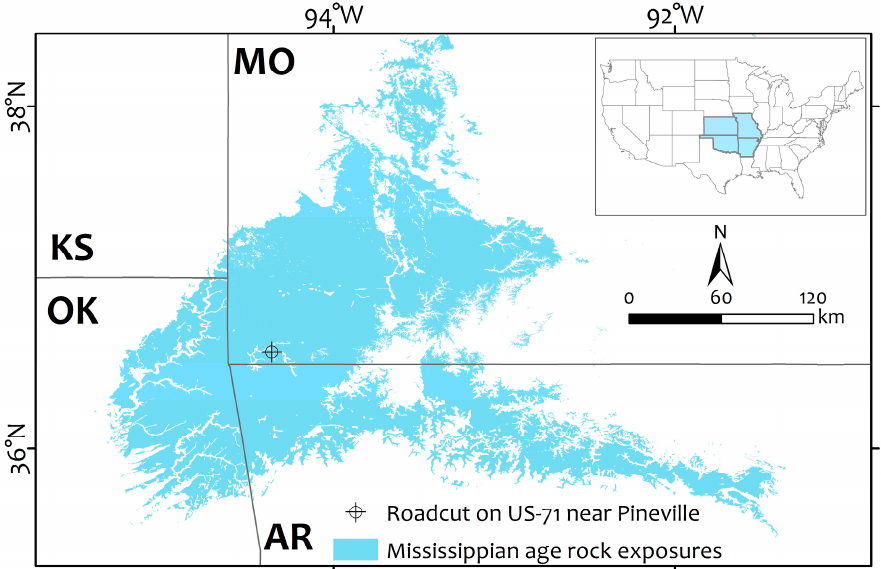
Figure 2. Mississippian rock exposures in the quad state area of southeast Kansas (KS), southwest Missouri (MO), northeast Oklahoma (OK), and northwest Arkansas (AR).The crosshair depicts the location of the roadcut on US-71 Hwy near Pineville, Missouri studied in this paper.